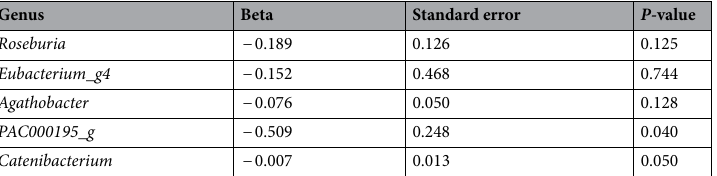
Table 2. The association between headache frequency and the relative abundance of microbiota. * *Poisson regression analyses at the genus level. Changes in headache frequency per month according to 1% increase in the composition of microbiota.